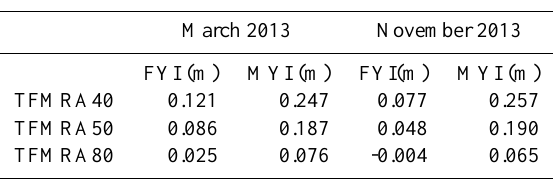
Table 2. Mean radar freeboard F R of gridded data for March and November 2013, discriminated between first-year ice (FYI) and multiyear ice